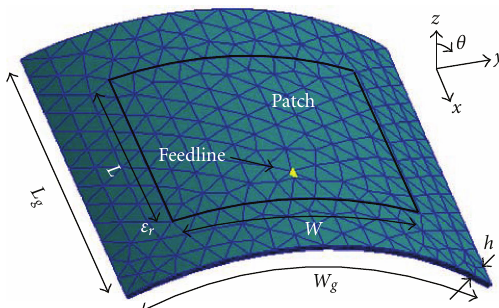
Figure 5: Geometry of a conformal microstrip antenna.